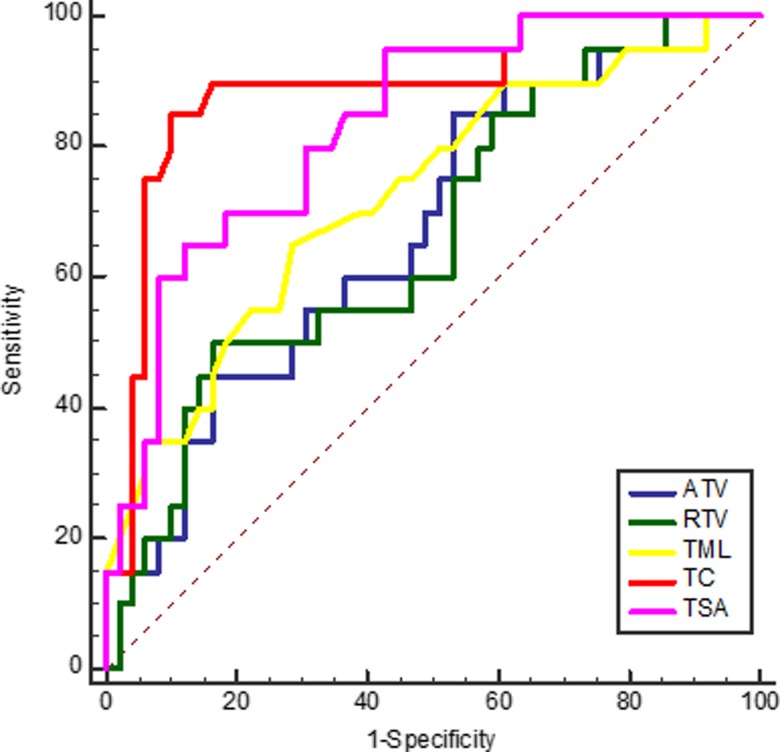
ROC curve of ATV, RTV, TML, TC and TSA using the pCR as test variable.